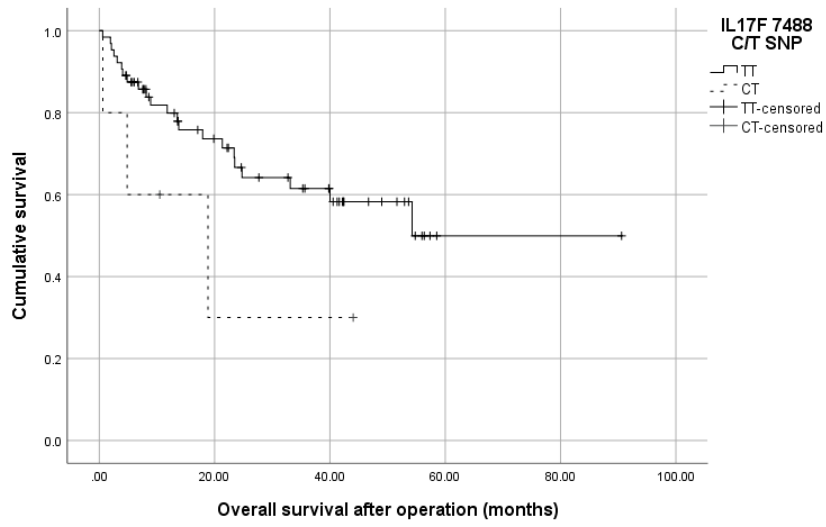
Figure 8. Kaplan–Meier survival curve of CRC patients according to IL17F 7488T/C genotypes. The C/T-carriers had shorter survival of 19.95 months compared to the T/T-genotype 56.12 months, ( p = 0.039, Log-rank test).